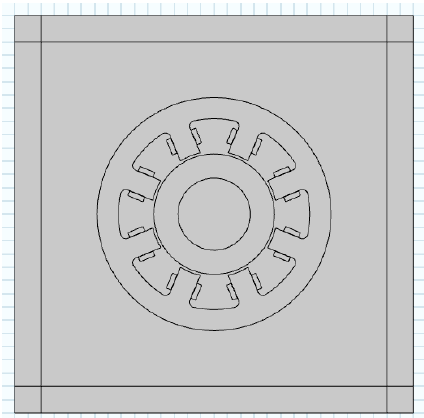
Figure 10. Two-dimensional finite element model of the designed self-inductive displacement sensor.